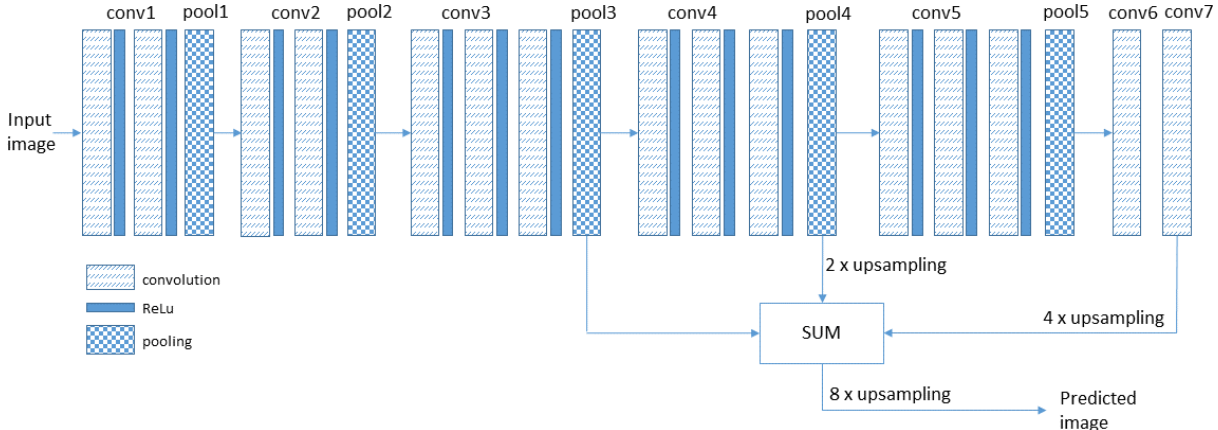
Figure 3: FCN-8 network